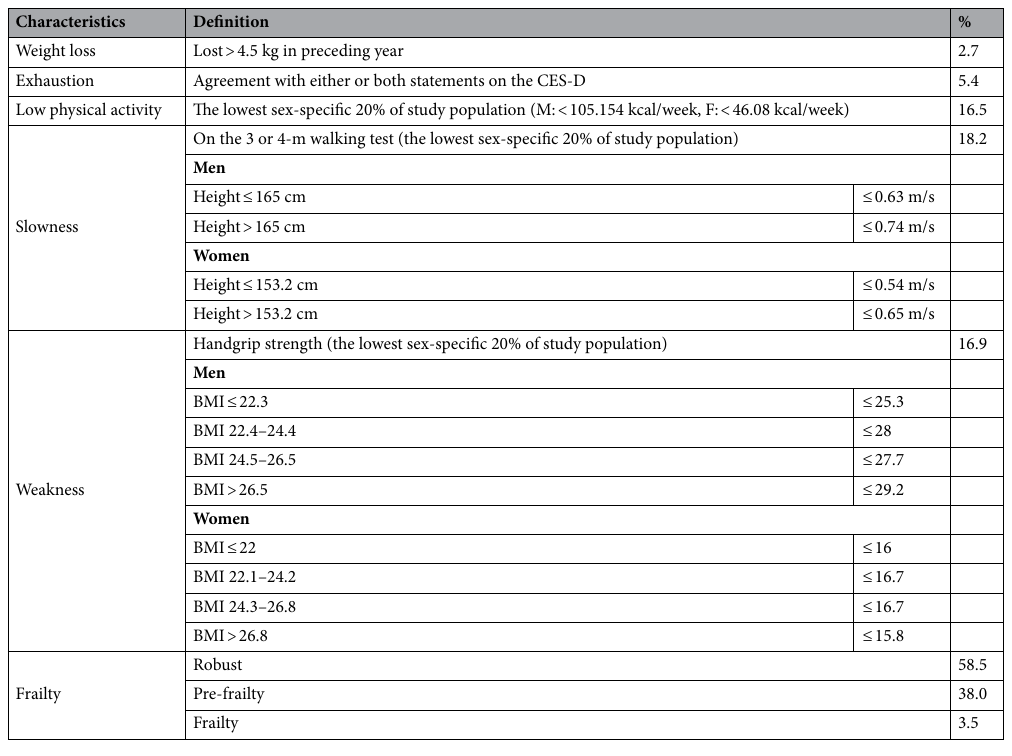
Table 4. Definition for physical